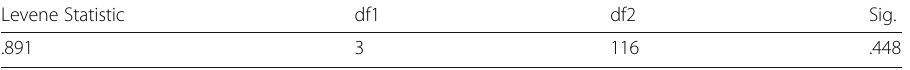
Table 6 Test of Homogeneity of Variances; Post-test Autonomy Levene Statistic df1 df2 Sig. .891